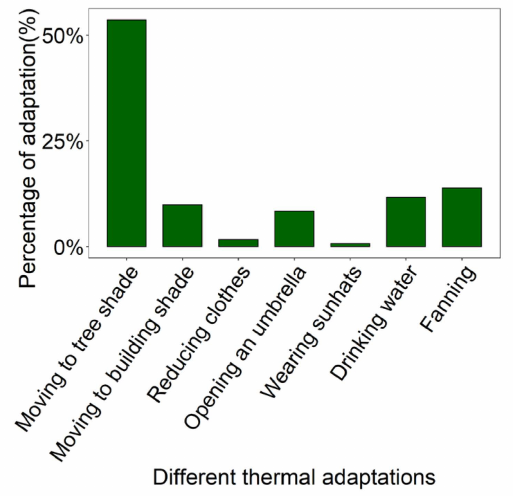
Figure 6. Thermal adaptive behaviors.